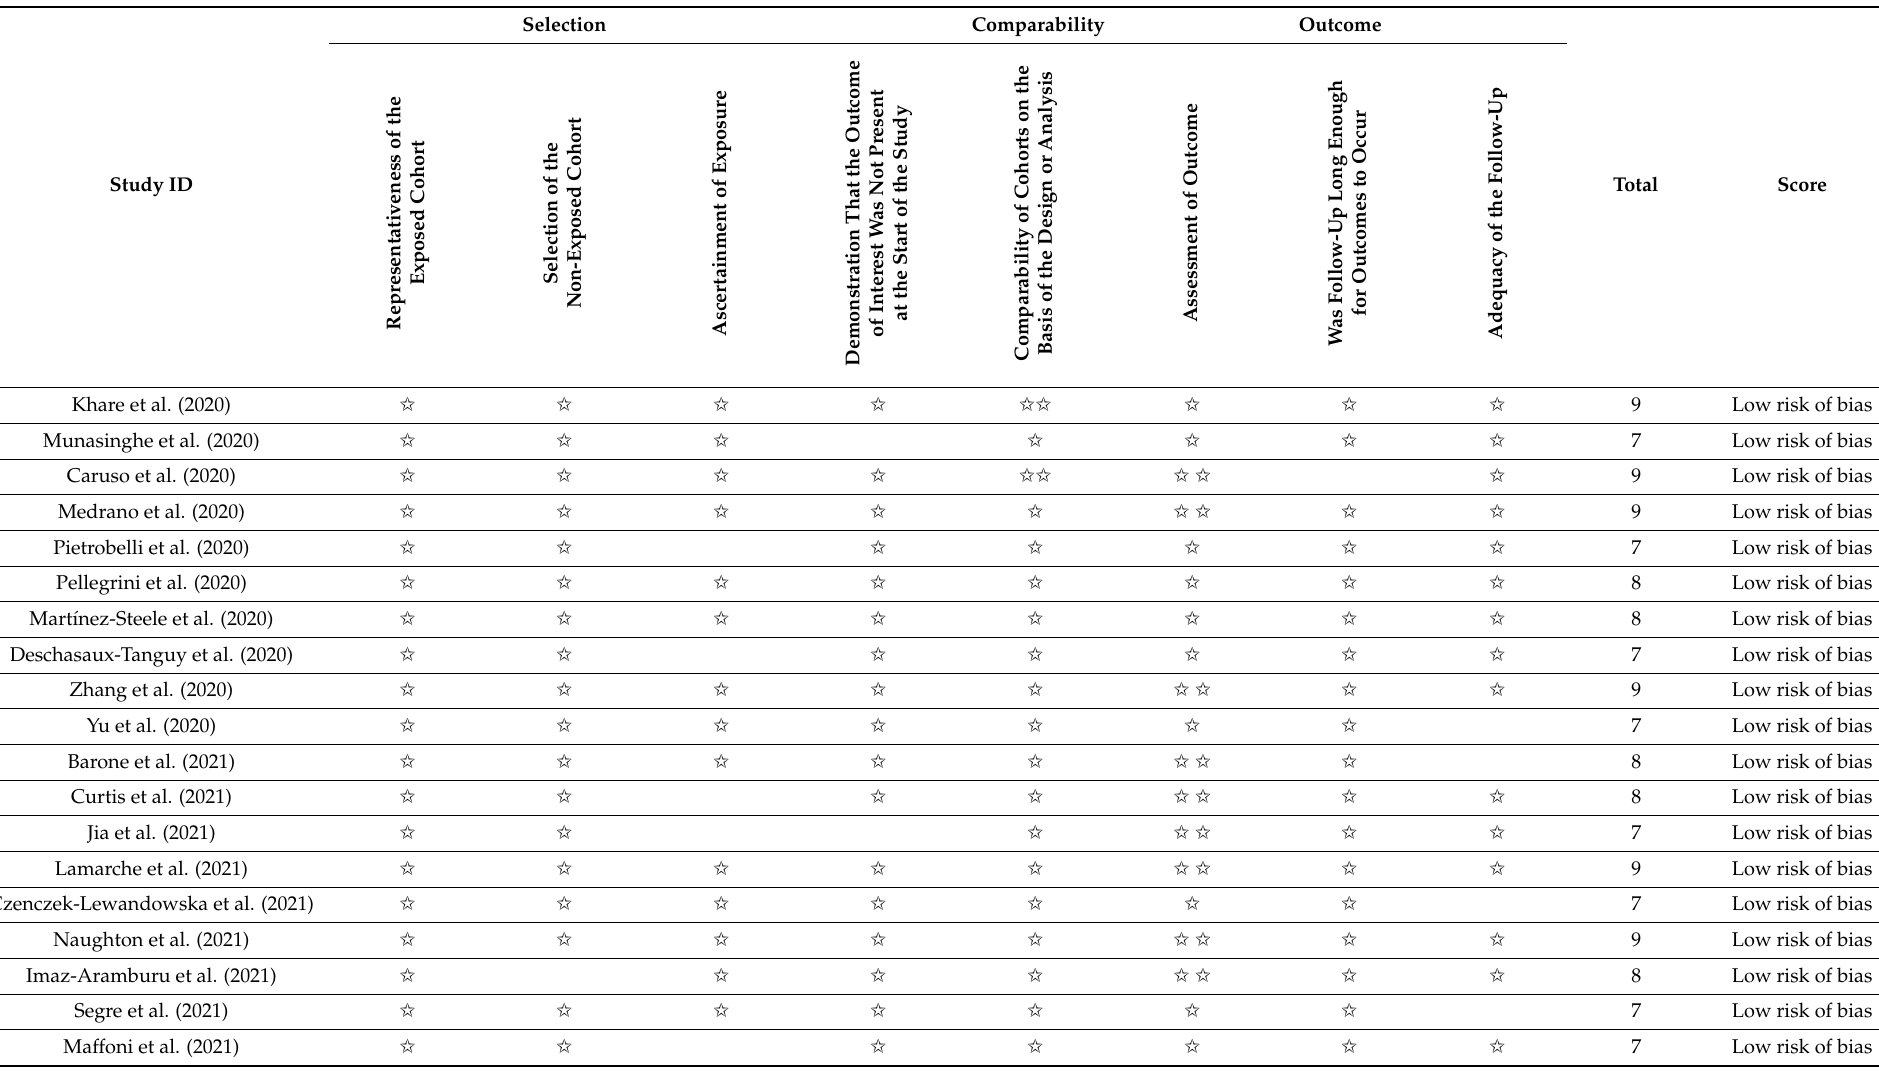
Table 5. Quality appraisal